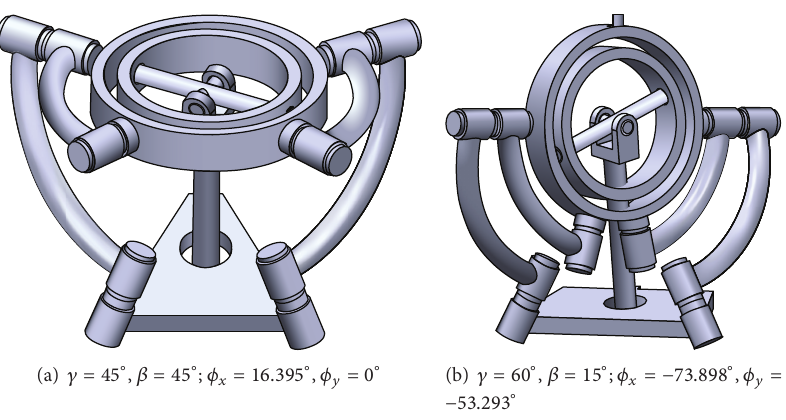
Figure 6: Examples of Type II singularity of the asymmetrical